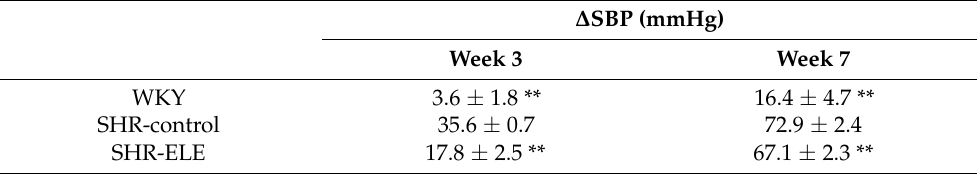
Table 1. The change in systolic blood pressure (SBP) during the seven-week study.